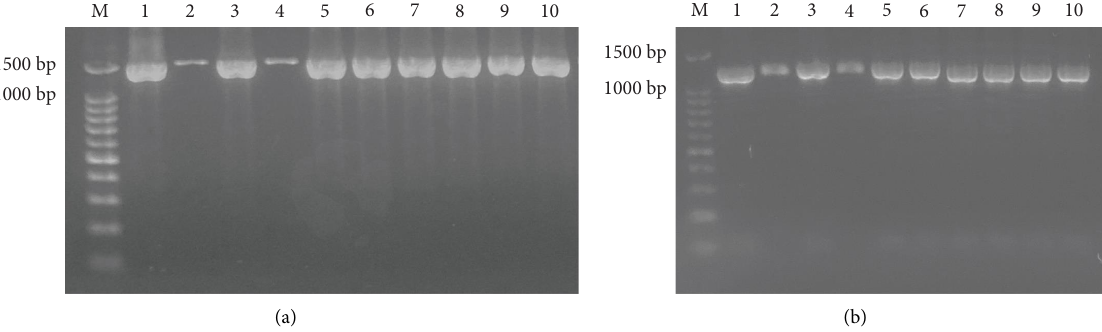
Figure 2: Results of PCR amplifcation targeting the 23S rRNA (a) and ompH (b) genes in P. multocida . Te 23S rRNA gene is one of the target genes that can be used to identify P. multocida . Its amplifcation product size is approximately 1,400bp [24]. Te ompH gene is a virulent gene that belongs to P. multocida, with an amplifcation product size of approximately 1,000bp [25]. M: DNA molecular markers;